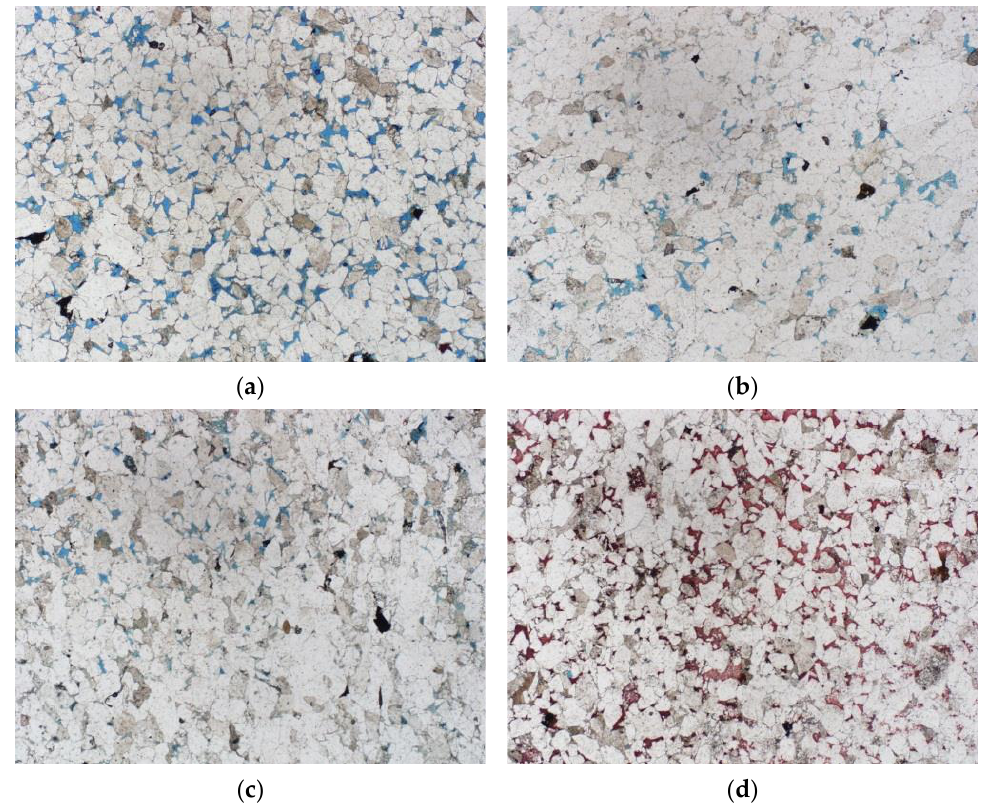
Figure 1. Sand casting body slice of well X1. ( a ) Well X1 4338.2 m; ( b ) Well X1 4321.7 m; ( c ) Well X1 5107.2 m; ( d ) Well X1 5116.8 m.